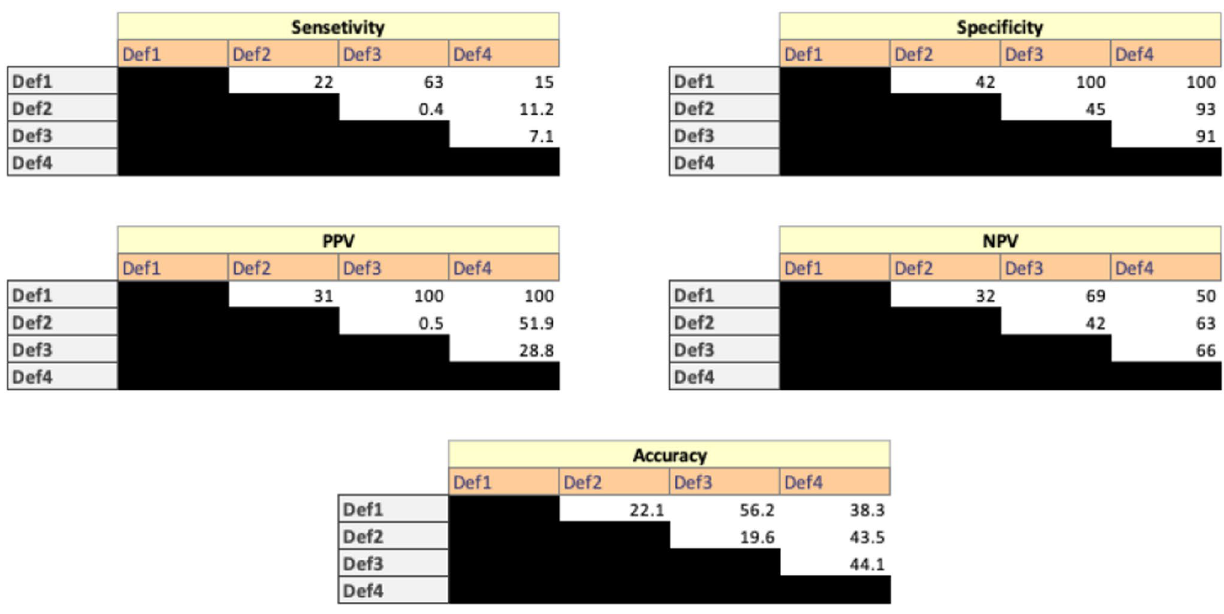
Fig. 1 Analysis matrix of all definitions